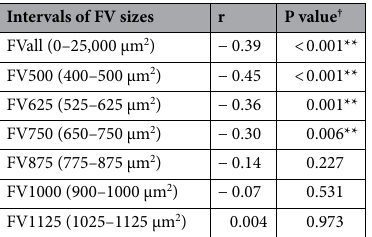
Intervals of FV sizes